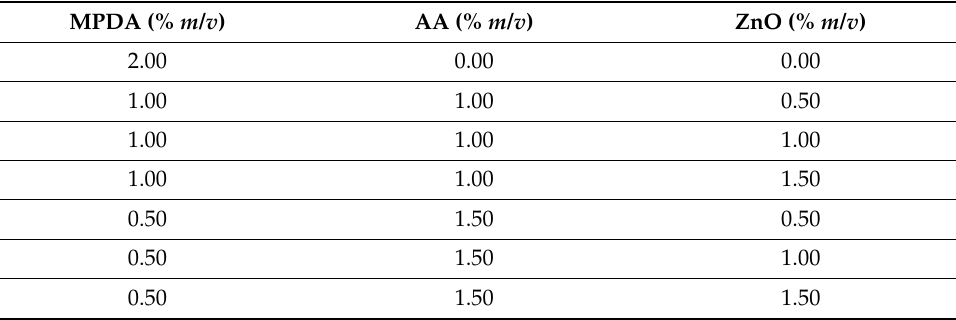
Table 1. Table showing different concentrations of m-phenylenediamine (MPDA) and acrylic acid (AA) on polyamide membrane